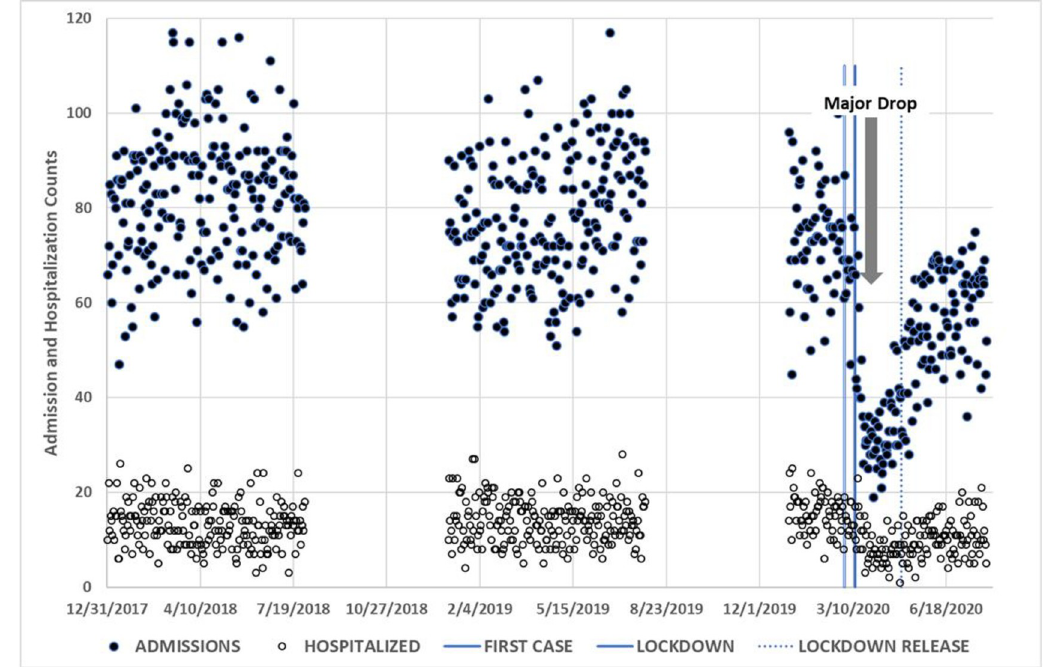
Fig 3. Plot of daily admission and hospitalization counts during 2018 to 2020. Vertical lines mark critical time points during the pandemic crisis: 1 March 2020, for first case discovered; 12 March 2020 for first lockdown; 1 May 2020 for lockdown release; Bold arrow shows a drop in PED admissions due to the